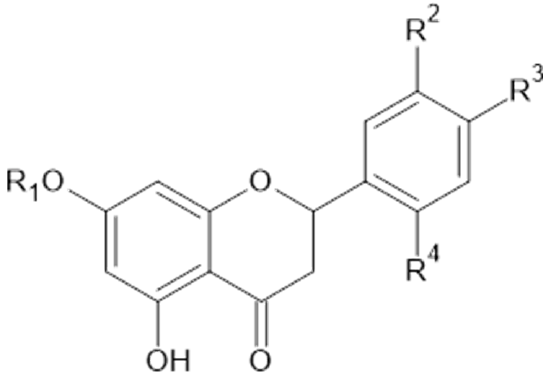
Figure 11. Chemical structure of compound 43 and 44 .